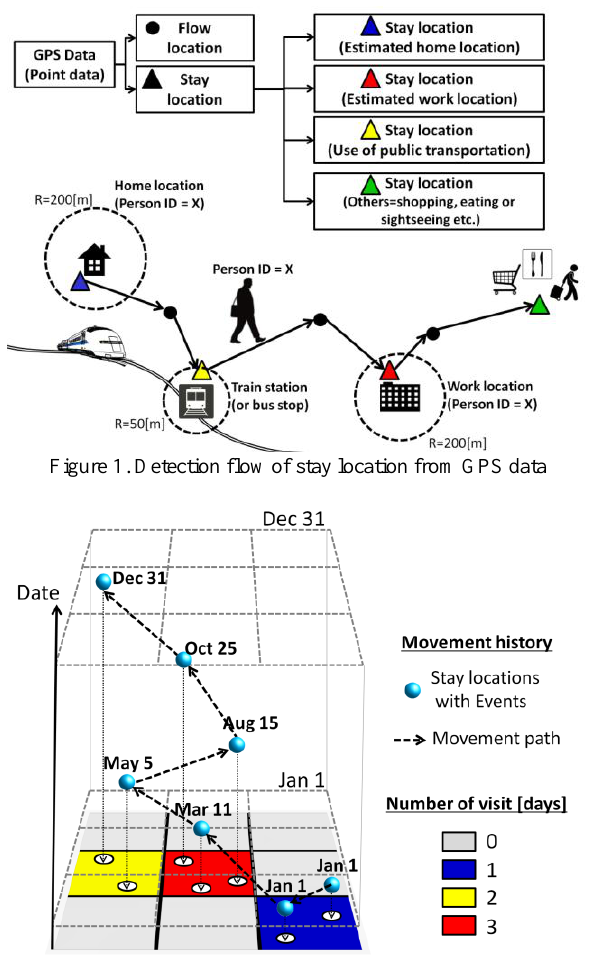
Figure 2. Image of calculation processing of number of visit in each Regional